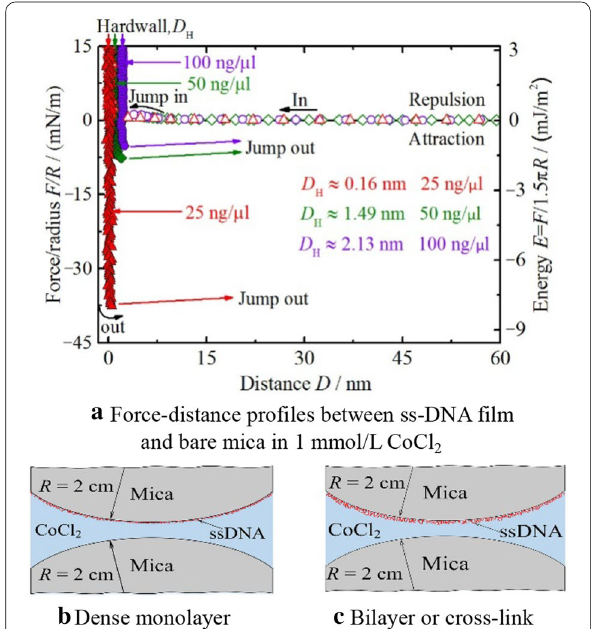
Figure 2 Force‑distance profiles between ss‑DNA layer and bare mica in 1 mmol/L CoCl 2 with different DNA concentrations: 25 (triangle), 50 (diamond), 100 ng/μL